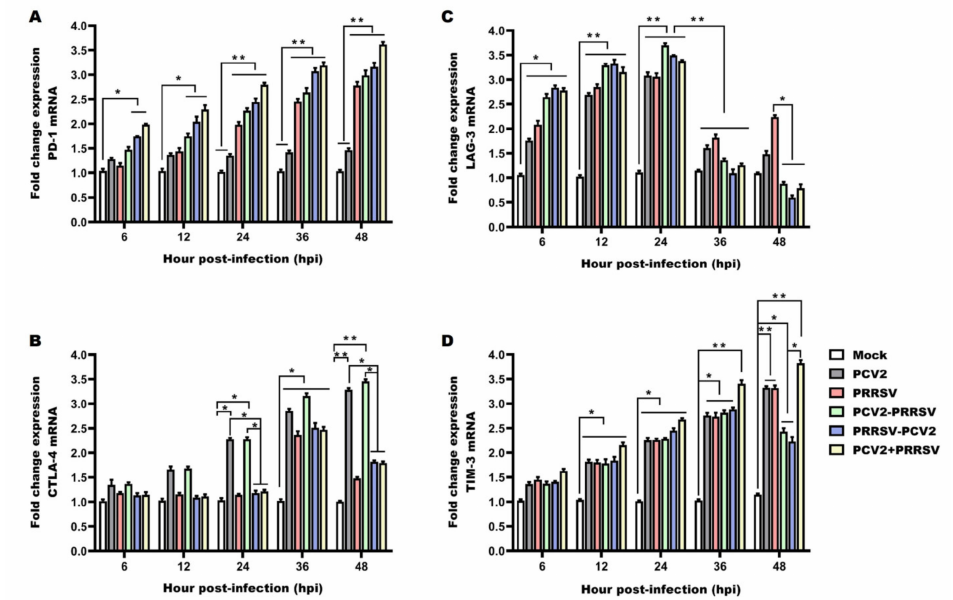
Figure 7. Relative mRNA expression of immune checkpoints. PAMs in the PCV2 alone group (PCV2), the PRRSV alone group (PRRSV) and the PCV2 and PRRSV co-infected groups (PCV2–PRRSV, PRRSV– PCV2 and PCV2 + PRRSV) were inoculated with PRRSV and/or PCV2 at a MOI of 1, respectively. PAMs in the mock group were inoculated with equal RPMI-1640 medium. Then, PAMs from these groups were collected at 6 h, 12 h, 24 h, 36 h and 48 h post-infection, respectively. RT-qPCR analysis of PD-1 ( A ), CTLA4 ( B ), LAG3 ( C ) and TIM3 ( D ) mRNAs in PAMs from different groups. Data are expressed as means ± SD of three independent experiments. Significant differences between groups are represented (** p < 0.01, * p <